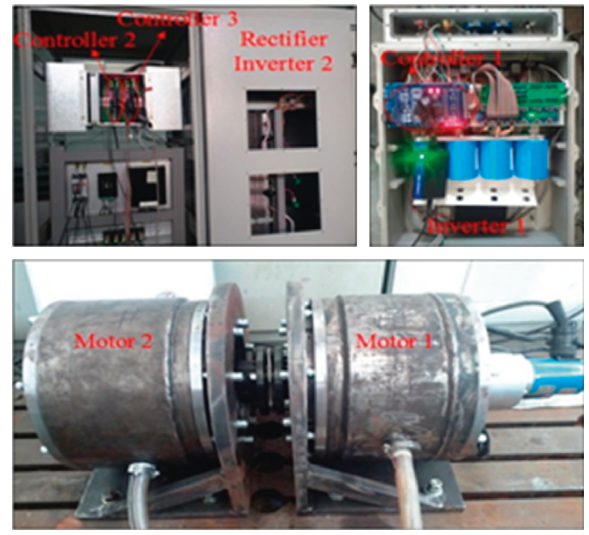
Figure 12: The experimental prototype.